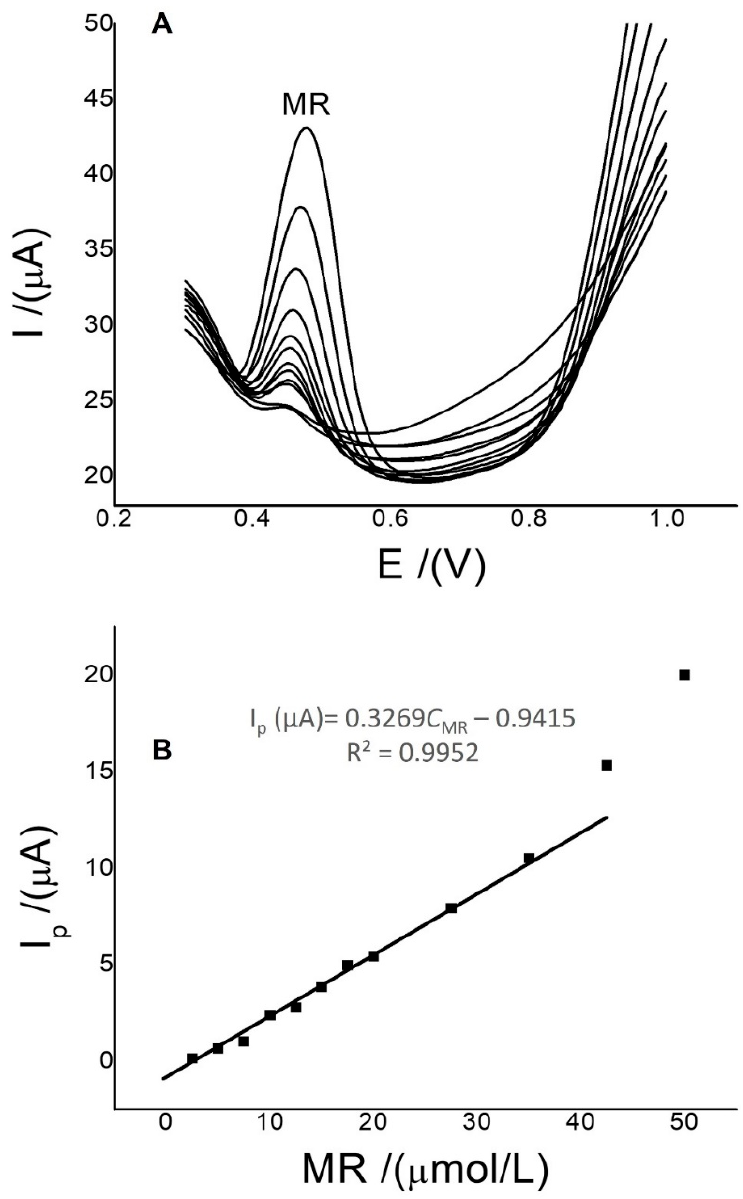
Figure 5. SWVs ( A ) and a calibration curve of MR ( B ) using Ch-G/GCE. Conditions: pH 3.0 (phosphate-buffered solution) at 0.0 V for 5 s. Frequency, 15 Hz; amplitude, 0.05 V; and potential increment, 0.01